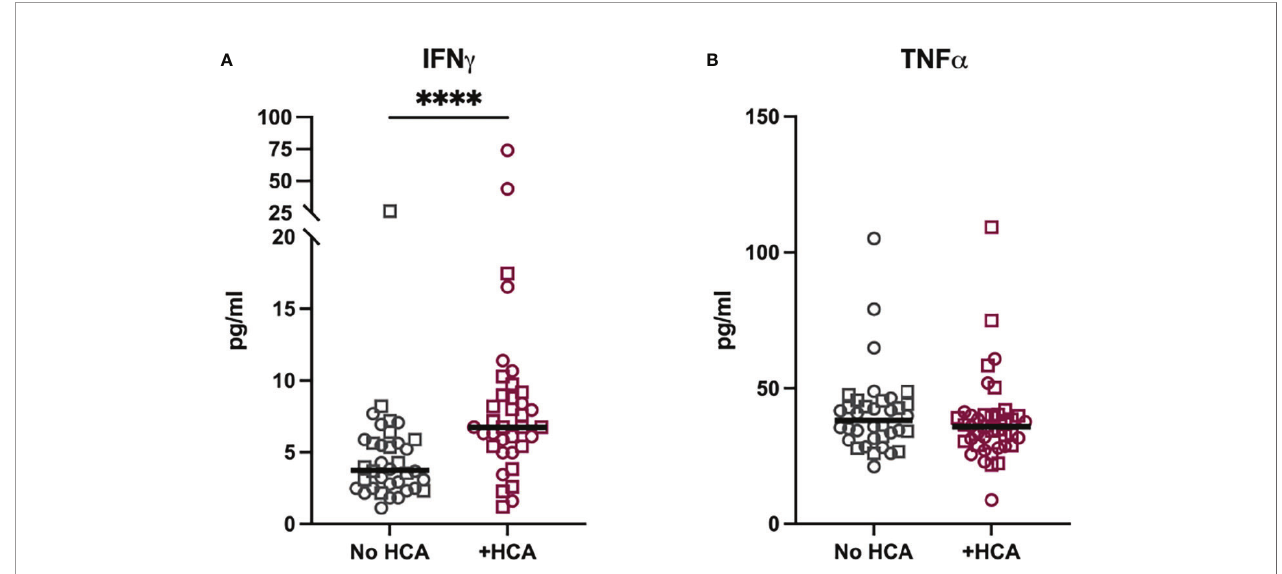
FIGURE 8 | Cord blood from neonates with histological chorioamnionitis have elevated IFN g . Cytokine levels were measured in a matched case-control study of cord blood plasma from term neonates (>37 weeks gestational age at delivery) with and without histological chorioamnionitis (HCA). (A) IFN g and (B) TNF a were measured by Milliplex assay in 41 cases with HCA and 36 controls. Neonatal sex is noted by symbol shape: squares are male and circles are female. Sex did not impact variance in cytokine levels as measured by two-way ANOVA. Differences in cytokine levels were analyzed by Mann-Whitney test. ****p<0.0001.